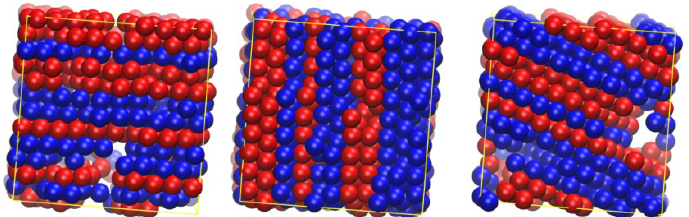
Figure 7. System configurations corresponding to the final crystal morphologies as obtained from MC simulations on N = 12 athermal polymer packing where chain lengths follow the Flory (most probable) distribution at volume fractions: (left) φ = 0.58, (middle) φ = 0.60 and (right) φ = 0.61. Spheres with high hcp and fcc similarities, according to the CCE norm, are depicted in blue and red colors, respectively. Image created using the VMD software